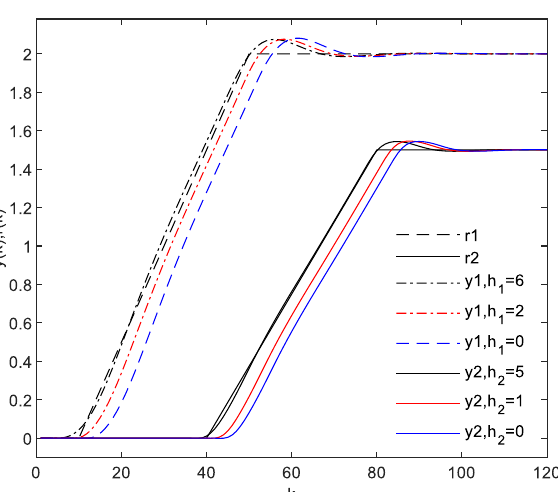
Figure 4. The control input of System (1) with